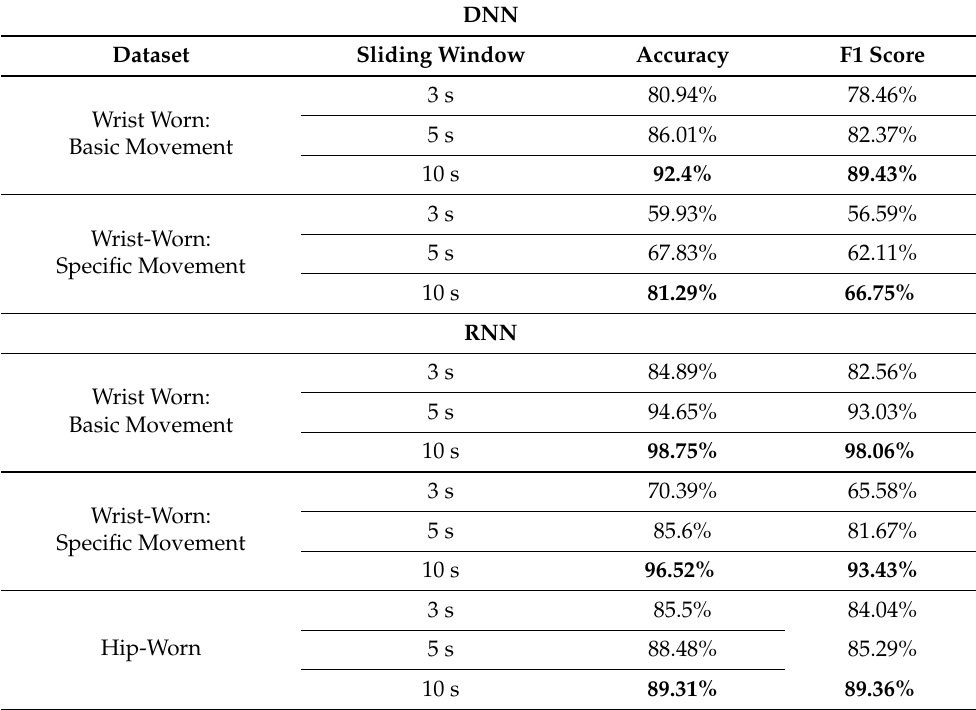
Table 5. Summary of the DNN and RNN